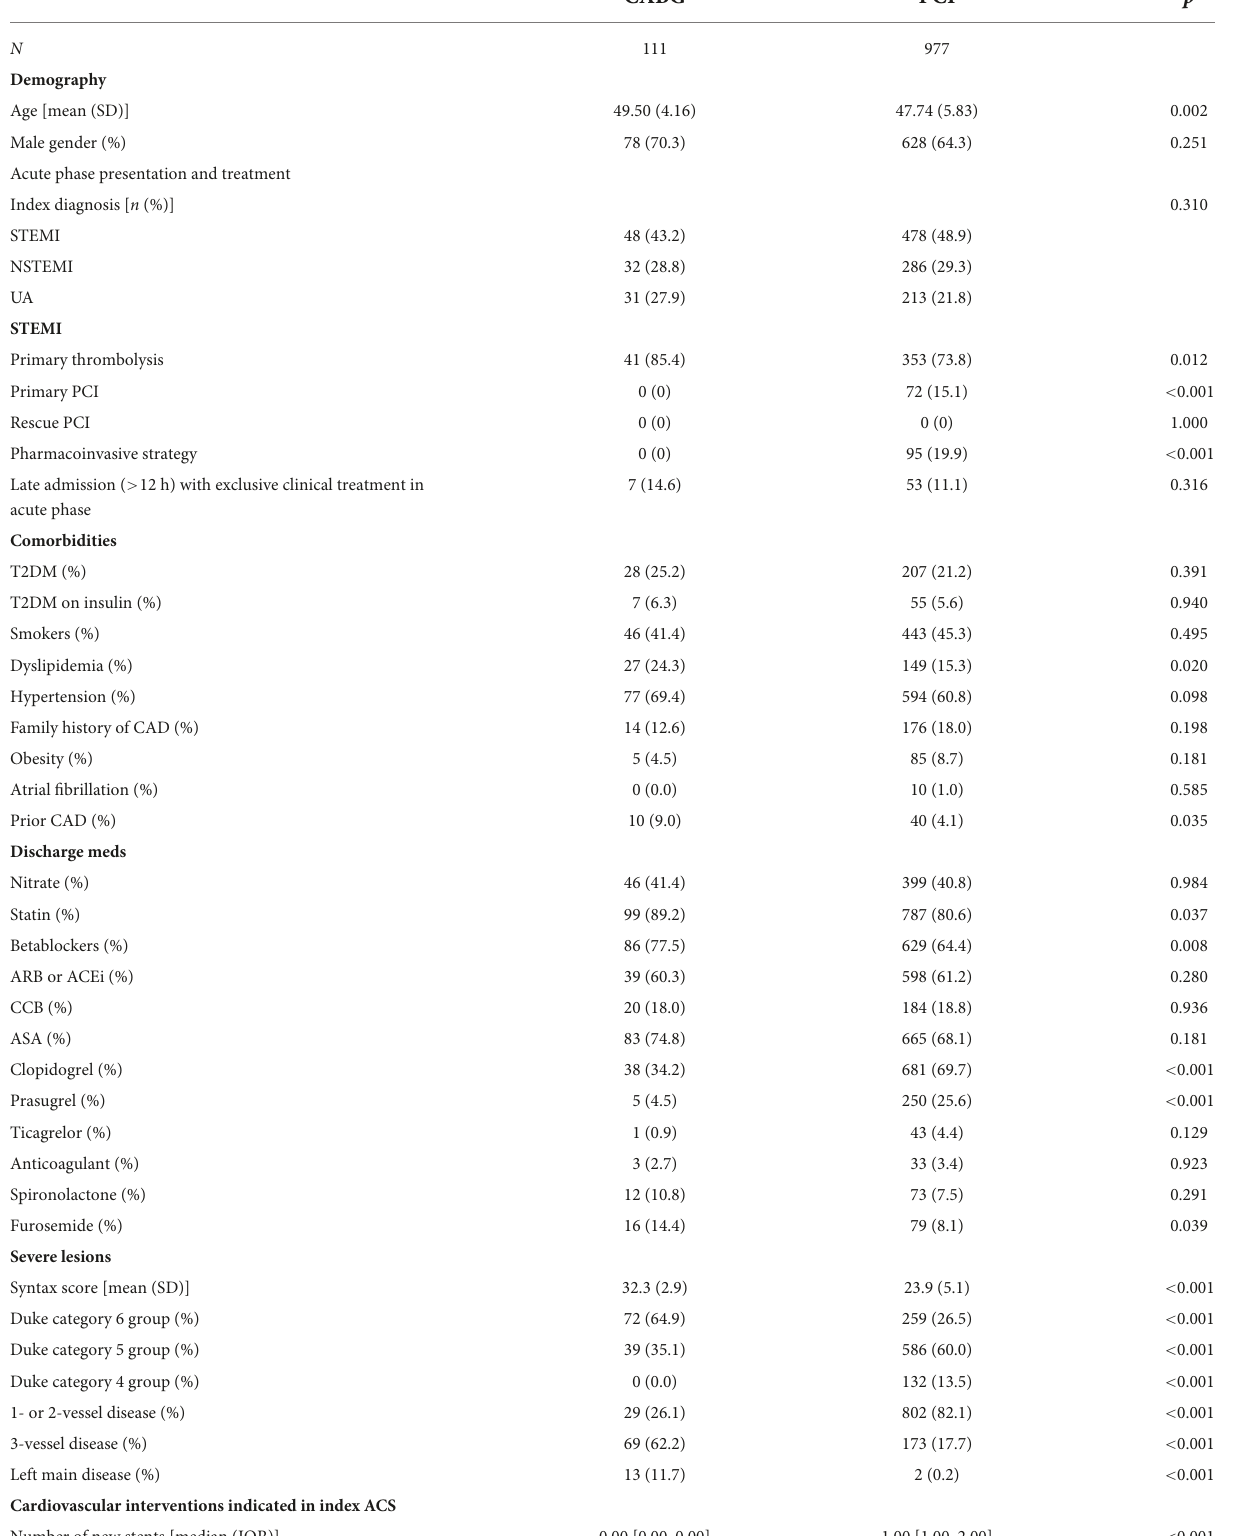
TABLE 3 Characteristics of enrolled